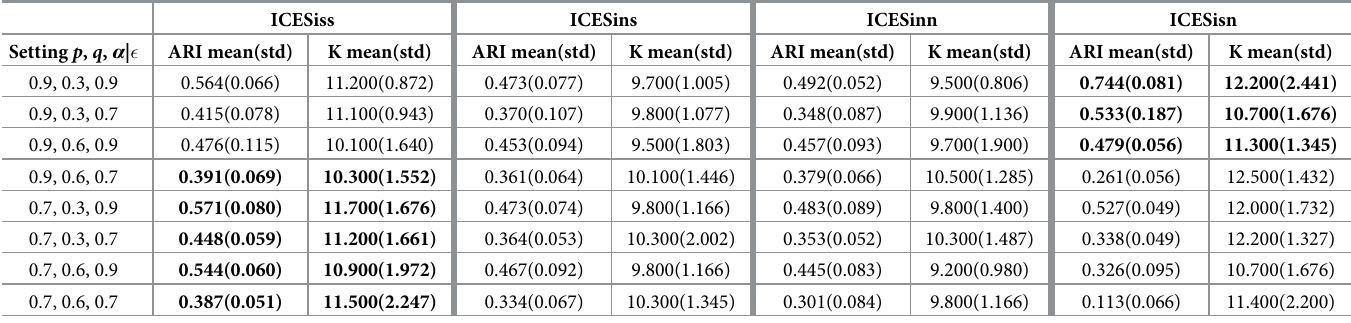
Table 20. The performance of ICESi methods at medium-size networks combining quantitative and categorical features at the nodes: The average ARI index and its standard deviation over 10 different data